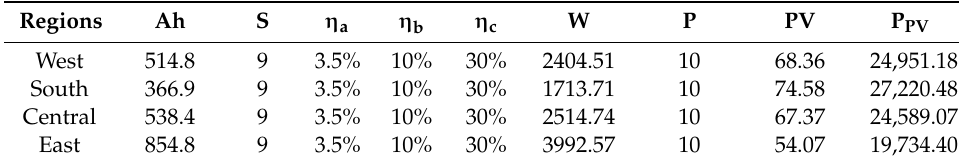
Table 9. 10 kW photovoltaic (PV) plant calculation.